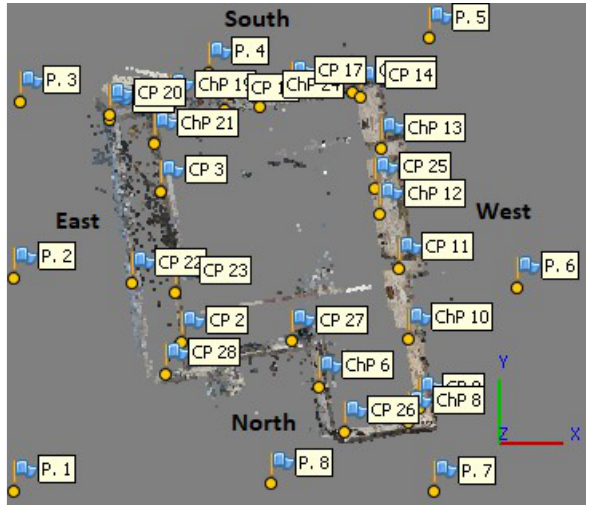
Fig. 1. Measurement object. (CP: Control point, ChP: Check point, P.: Traverse point)